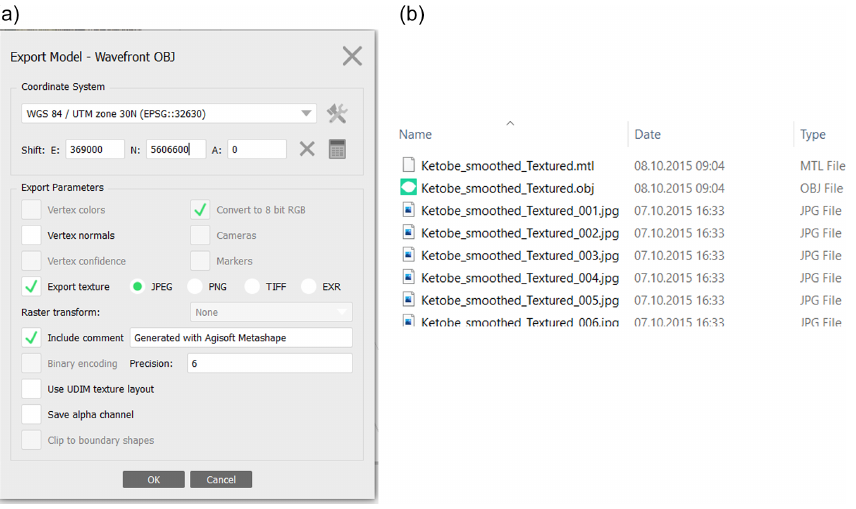
Figure A4. (a) Export parameters recommended for V3Geo (Agisoft Metashape). (b) Disk file structure of the output OBJ model, including associated .mtl and texture